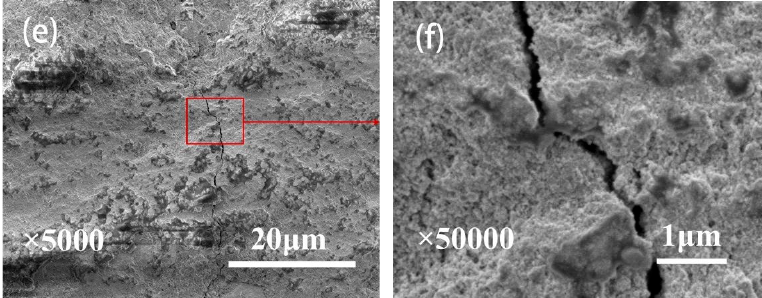
Figure 12. SEM morphologies of the wear scars of coatings after the oxidation temperature of 200 °C : ( a ) 1 h and 5000× magnification; ( b ) 1 h and 50,000× magnification; ( c ) 3 h and 5000× magnification; ( d ) 3 h and 50,000× magnification; ( e ) 5 h and 5000× magnification; and ( f ) 5 h and 50,000× magnification.